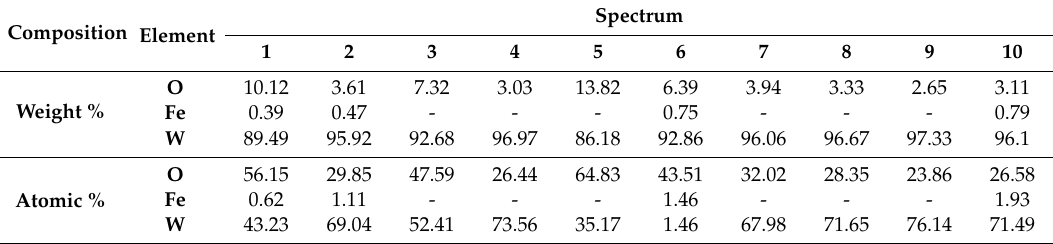
Table 3. The elemental composition of the S1 sample annealed at T = 750 °C, in the selected points.